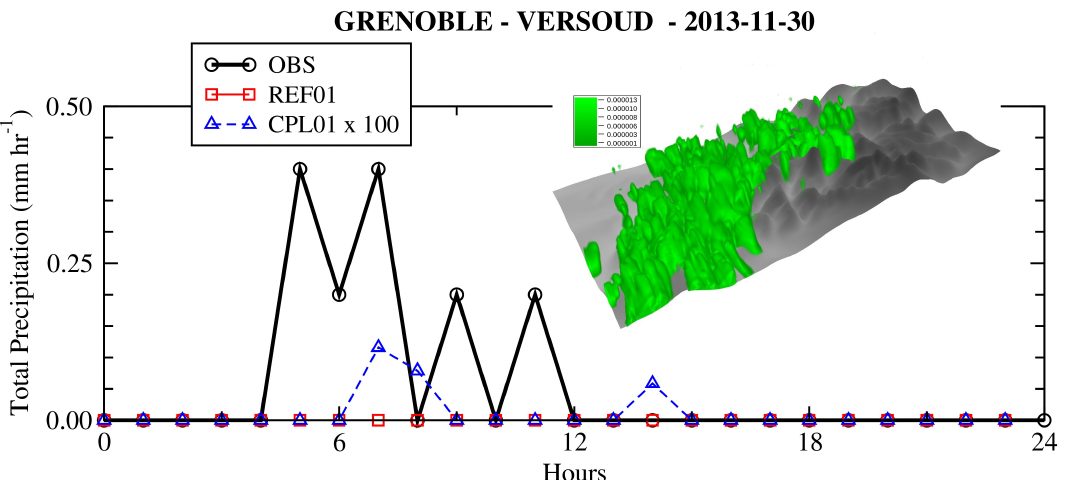
Figure 10. Impact of the on-line coupling on precipitations rates at 1 ⁄ 90 ◦ resolution (GRE0011) on 30 November. The green 3D shade show the delta of precipitations over GRE0011 between CPL01 and REF01 at 06:00